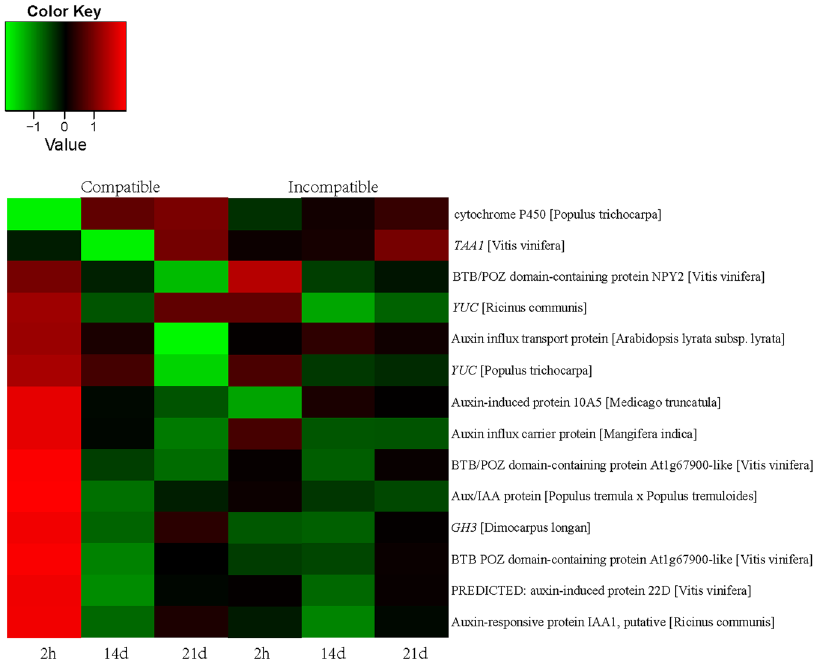
Figure 6. Heat map diagram of relative gene expression levels of DEGs related to auxin pathway. Red color indicates a relative increase in expression, and green color represents a relative decrease in expression.